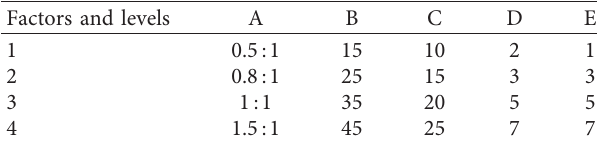
Table 5: Orthogonal factors and